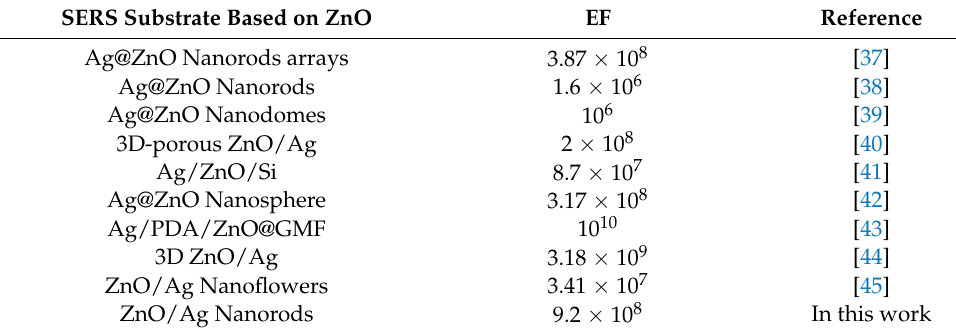
Figure 7. ( a ) SERS spectra of RhB at a concentration of 10 − 5 M to 10 − 11 M. ( b ) The logarithm of RhB concentration and Raman intensity plot at peak 1648 cm − 1 . Table 2. Comparison of EF of different ZnO/Ag